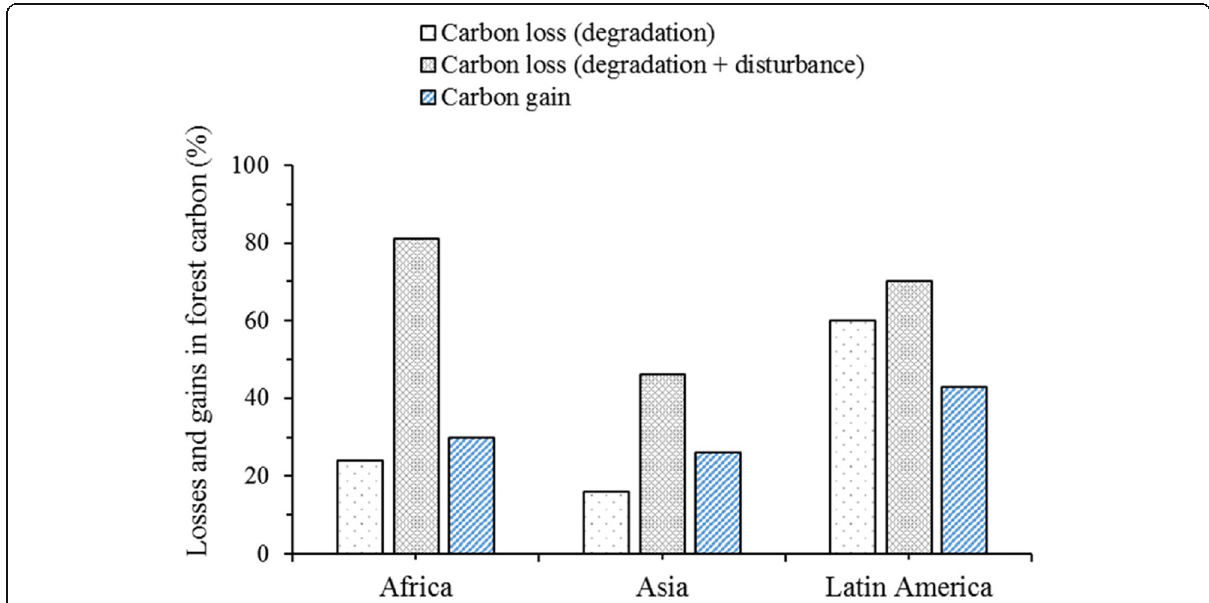
Fig. 2 Estimated losses and gains of forest carbon in tropical forests on continental scales (Source: adapted from Baccini et al. 2017